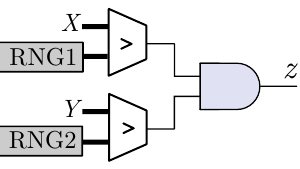
Figure 12. Multiplication test